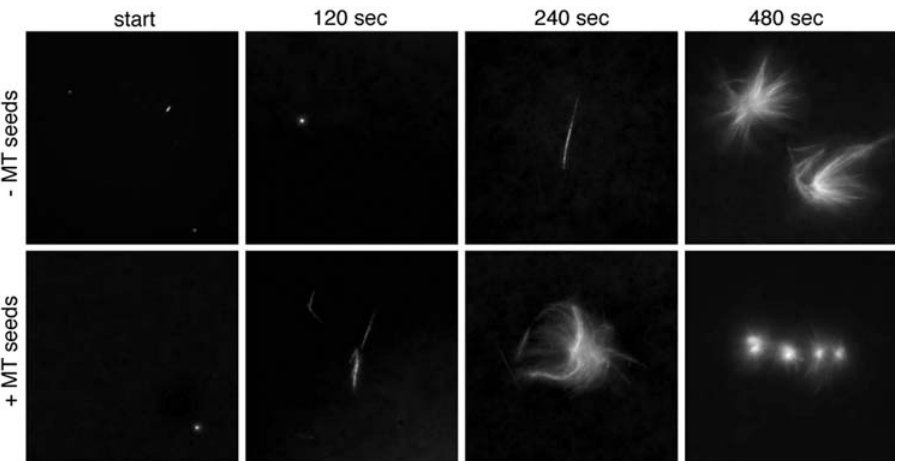
Figure 2. Taxol stabilized MT seeds strongly promote MT production and aster assembly in meiotic Xenopus egg extract. The two time series shown here were prepared as in Figure 1A but with addition of soluble Taxol (top series) or Taxol stabilized MT seeds (bottom series). Without MT seeds, the first traces of MTs were visible after , 240 sec and organized asters (of 10–30 m m diameter) were visible after , 480 sec. With MT seeds, organized asters were visible already after , 240 sec. Thus, MT seeds speed up MT production by , 240 sec. This supports a model where MTs induce the production of more MTs and that this mechanism is responsible for the assembly of MT super-structures.